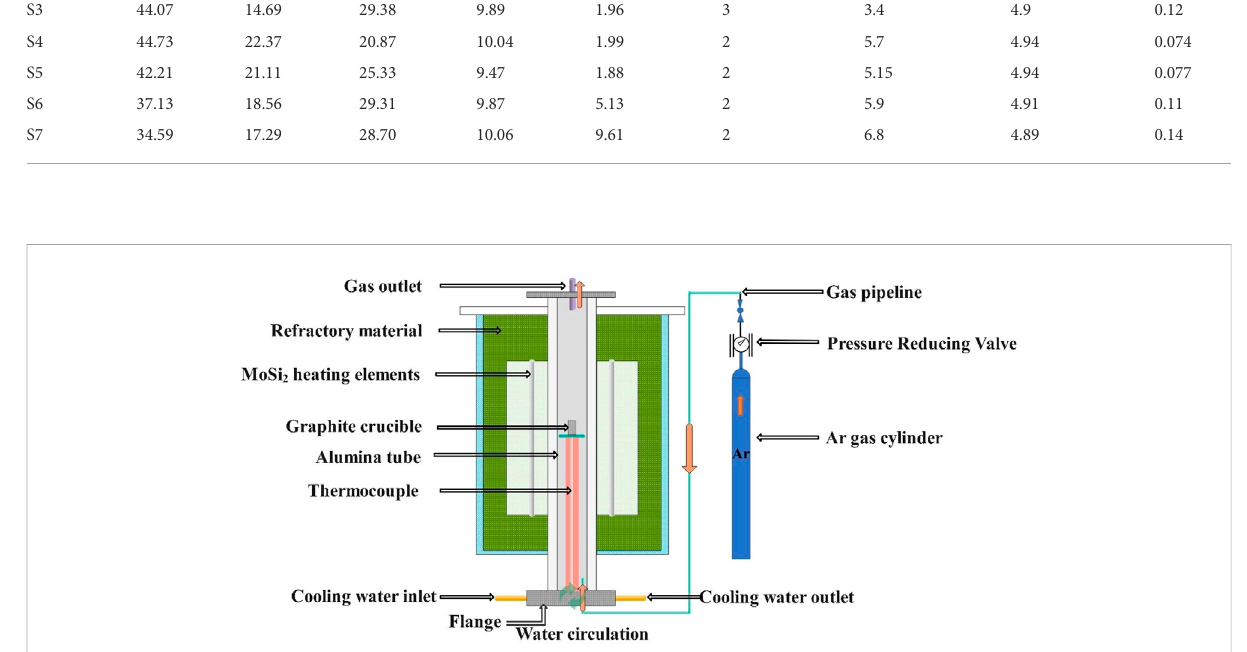
FIGURE 5 Schematic diagram of the experimental apparatus used in the present